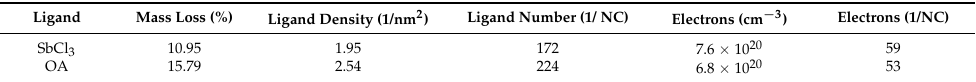
Table 1. Ligand attachment and its effect on carrier